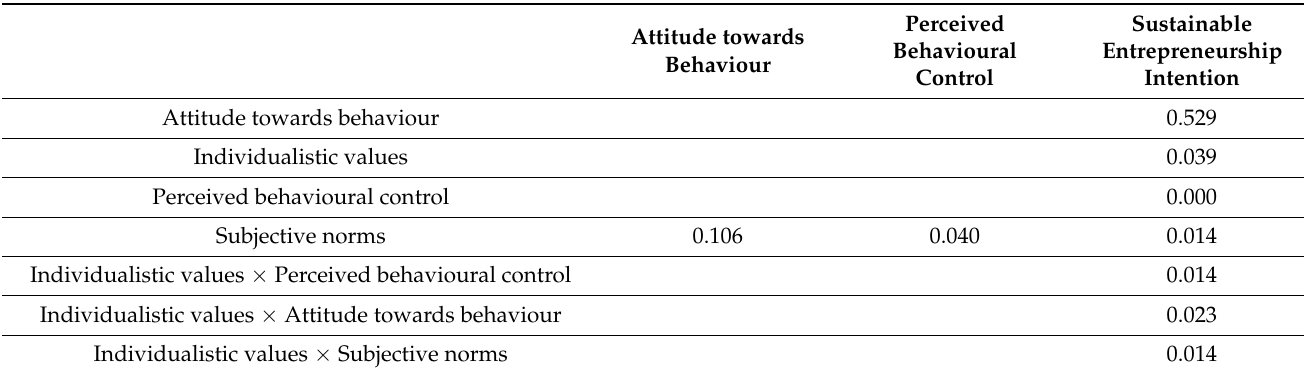
Table 7. F-square effect sizes.